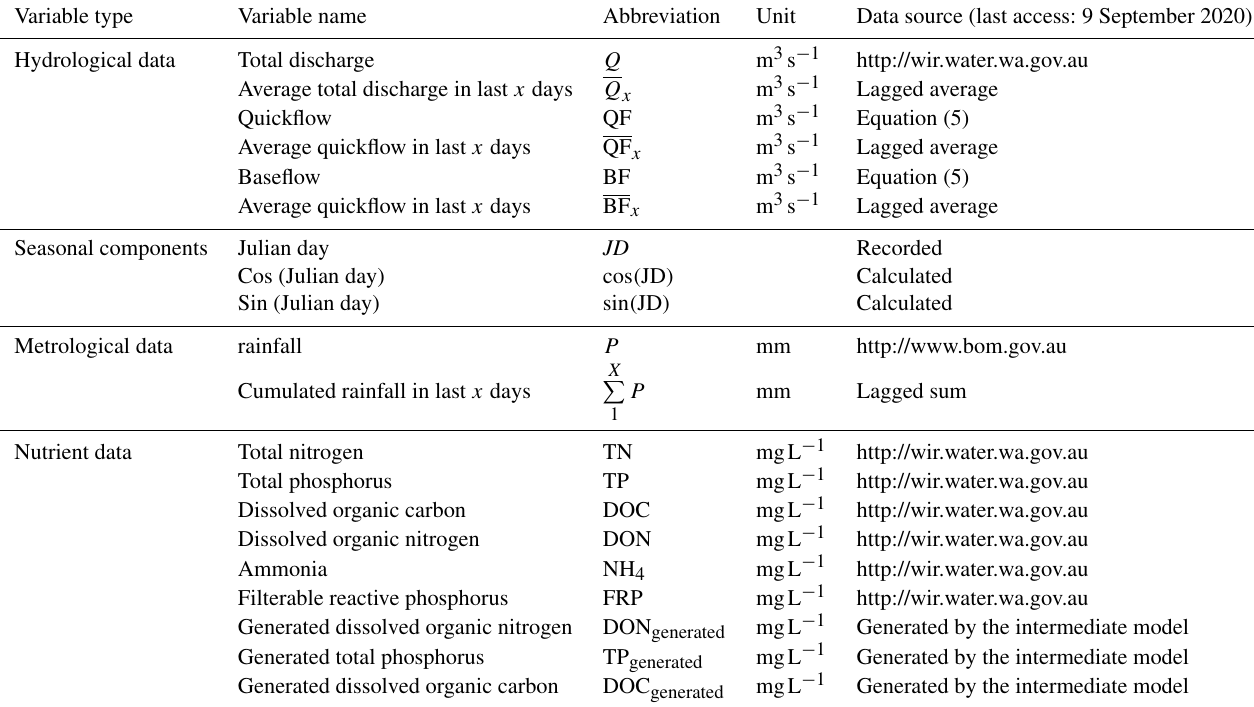
Table 1. Variable list and descriptions.